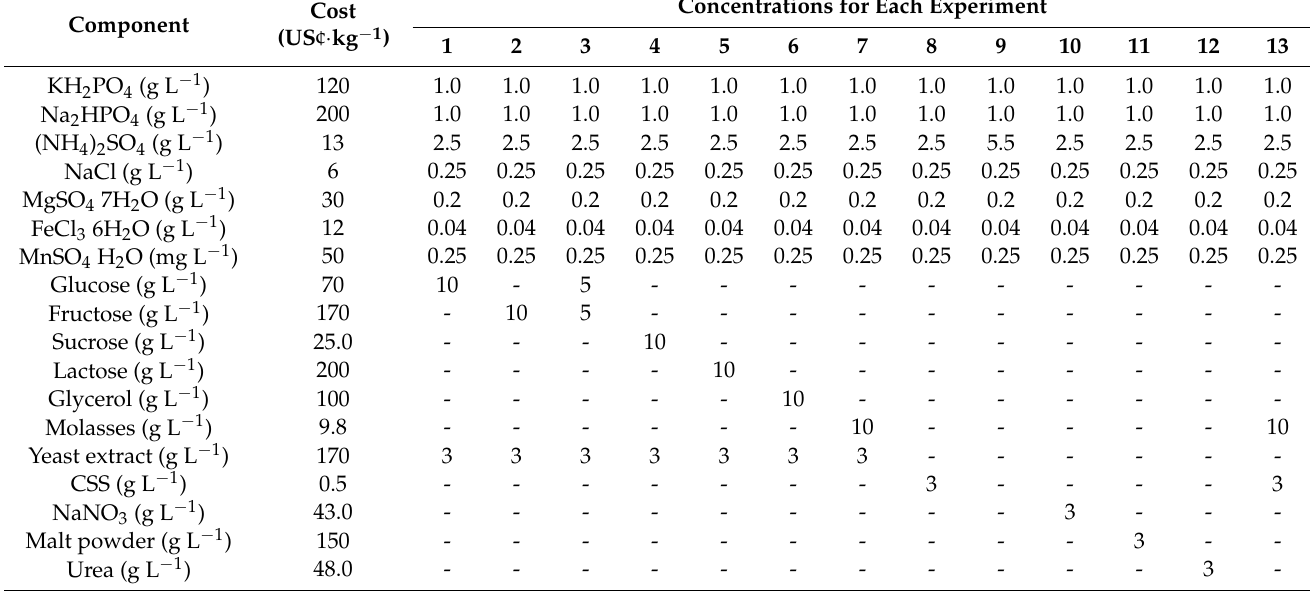
Table 2. Concentrations and costs in dollar cents (US¢) of each medium component used in the different shake flask cultures studied, namely standard medium (experiment 1), medium 2